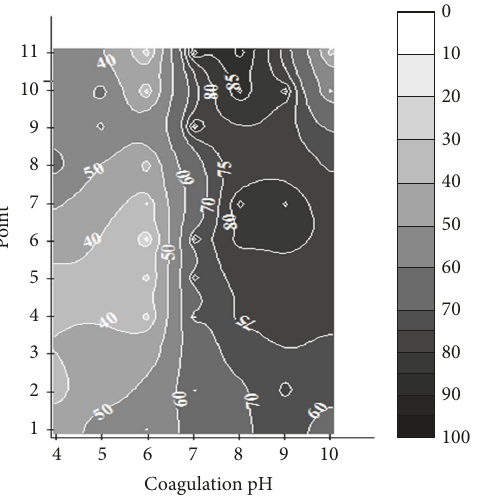
Figure 6: Coagulation diagrams with curves of compounds with UV 254 nm absorption removal in percentage